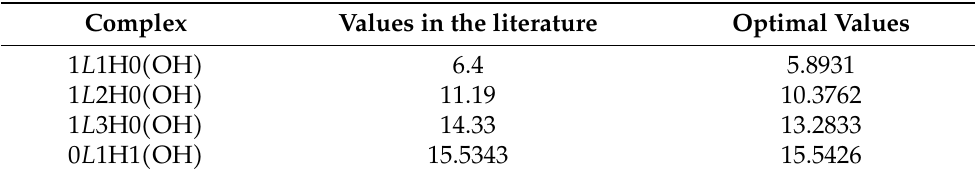
Table 6. Results of optimization given for the titration curve given in Figure 8. Values given as β . log 10